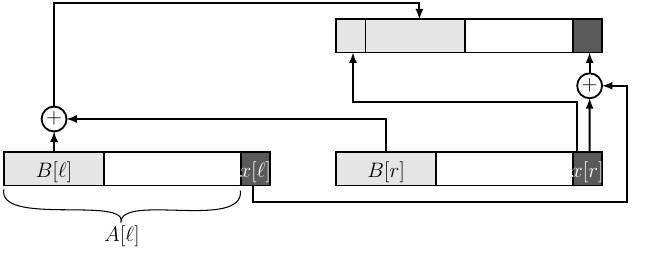
Figure 2. Schematical view of the work of a single